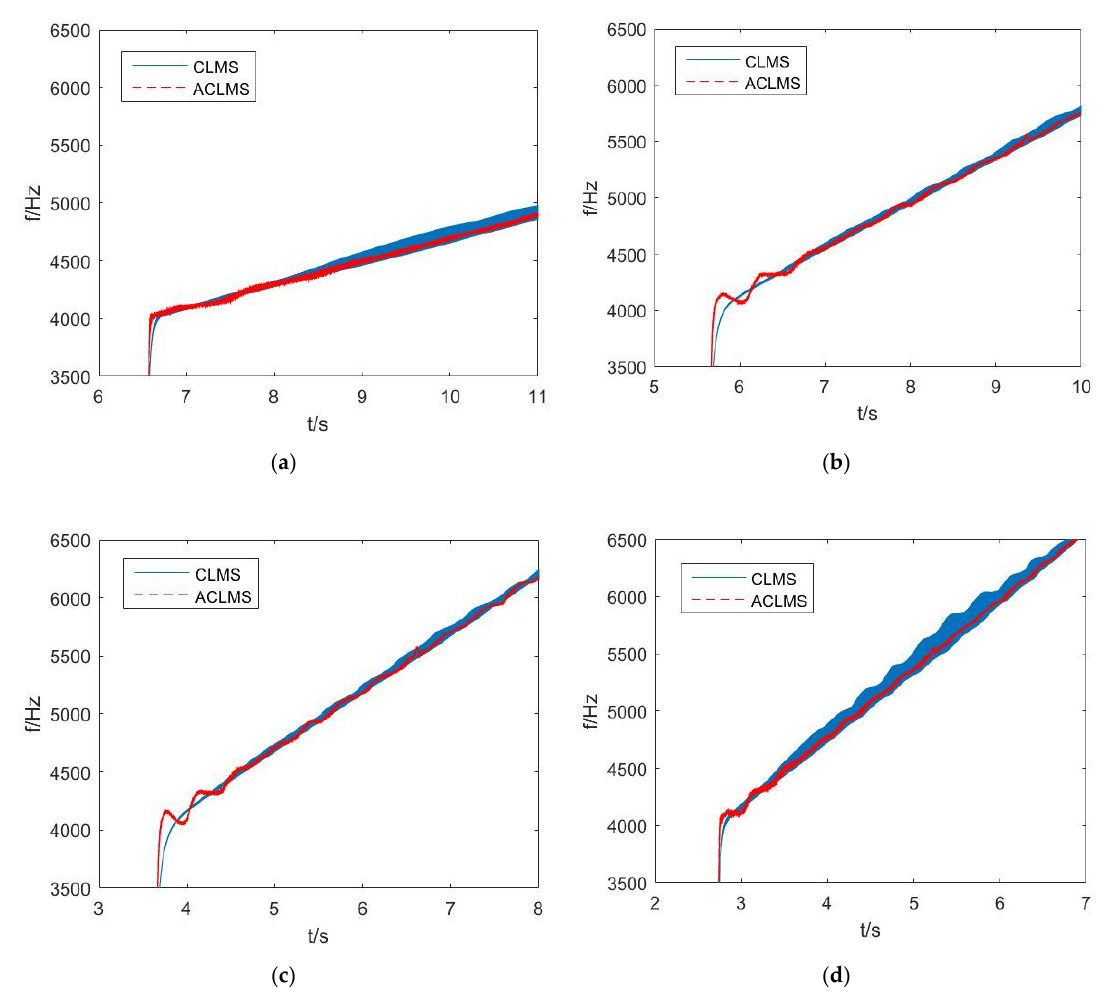
Figure 12. Experiments using LFM signals with different modulation rate: ( a ) 200 Hz/s; ( b ) 400 Hz/s; ( c ) 500 Hz/s; ( d ) 600 Hz/s.